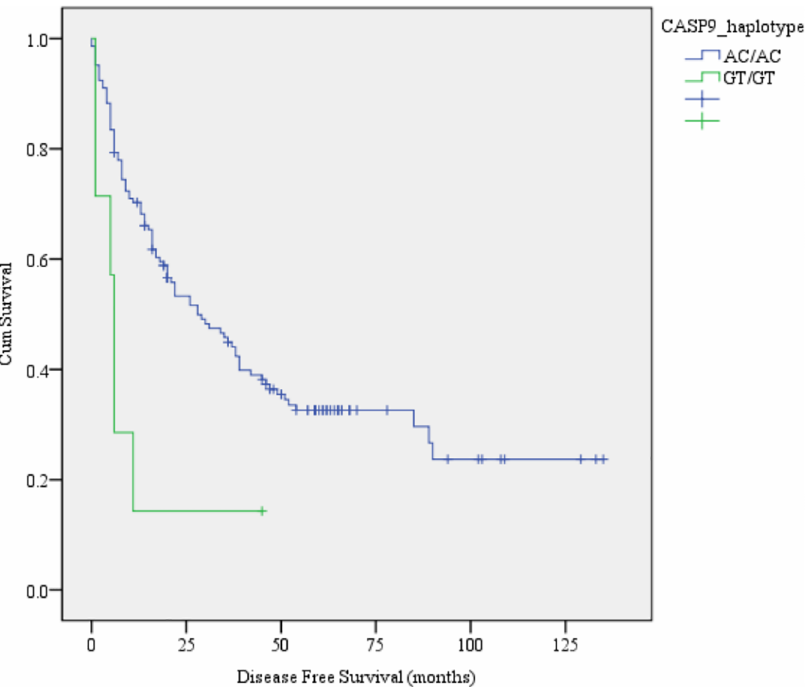
Fig 3. Kaplan-Meier survival curves of CASP9 _haplotype with disease free survival of HCC